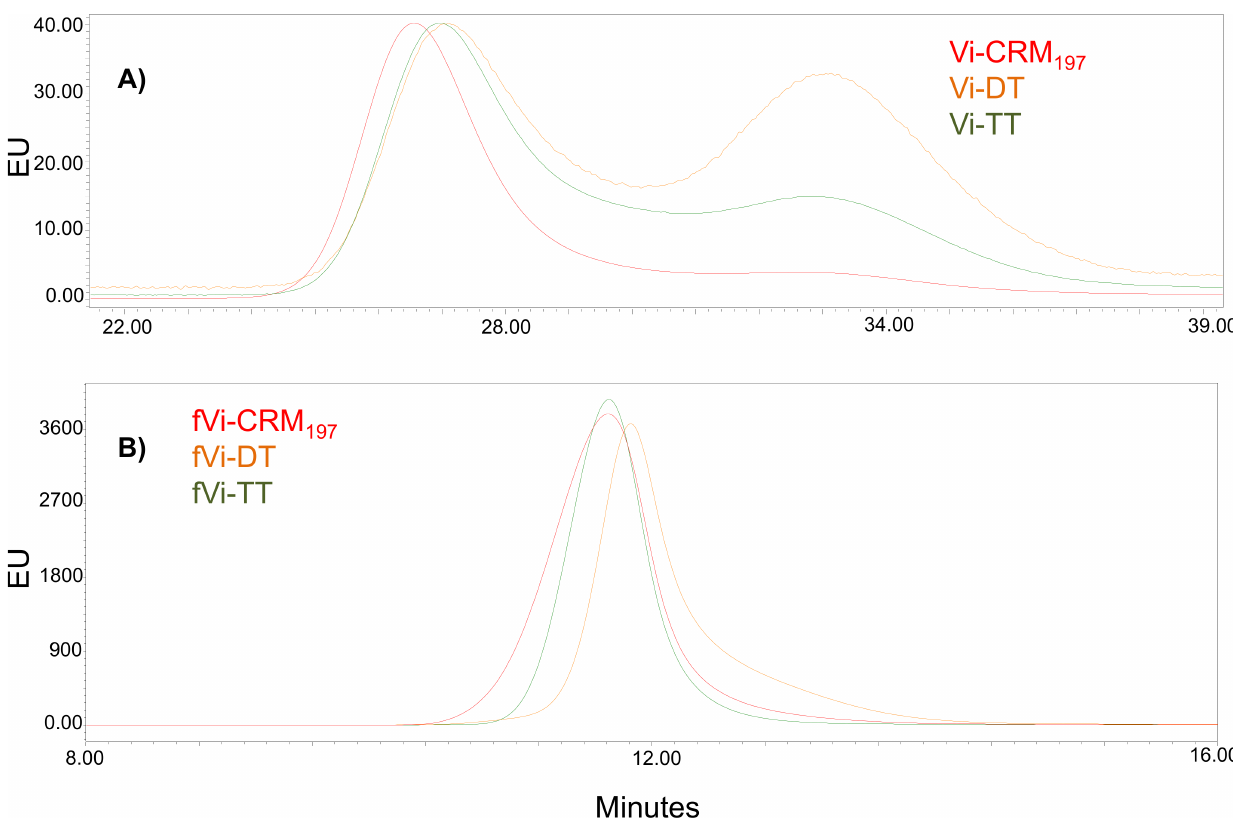
Fig 1. A) HPLC-SEC profiles (fluorescence emission detection) of Vi-CRM 197 (red), Vi-DT (orange) and Vi-TT (green). TSK gel 6000–5000 PW columns, NaCl 0.1 M NaH 2 PO 4 0.1 M ACN 5%, pH 7.2; flow 0.5 mL/min; V tot 49.004 min; V 0 24.382min. B). HPLC-SEC profilesof fVi-CRM 197 (red), fVi-DT (orange),fVi-TT (green). TSK gel 3000 PWxl column; NaCl 0.1 M NaH 2 PO 4 0.1 M ACN 5%, pH 7.2; flow rate 0.5 mL/min; V tot 23.326 min,